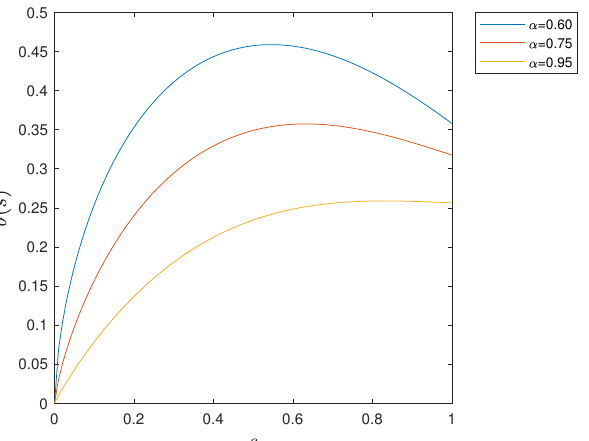
Figure 2. Approximated solutions for θ (tangent angle) of a cantilever beam with a uniformly distributed load P = 0.73 for α = 0.6,0.75, and 0.95.